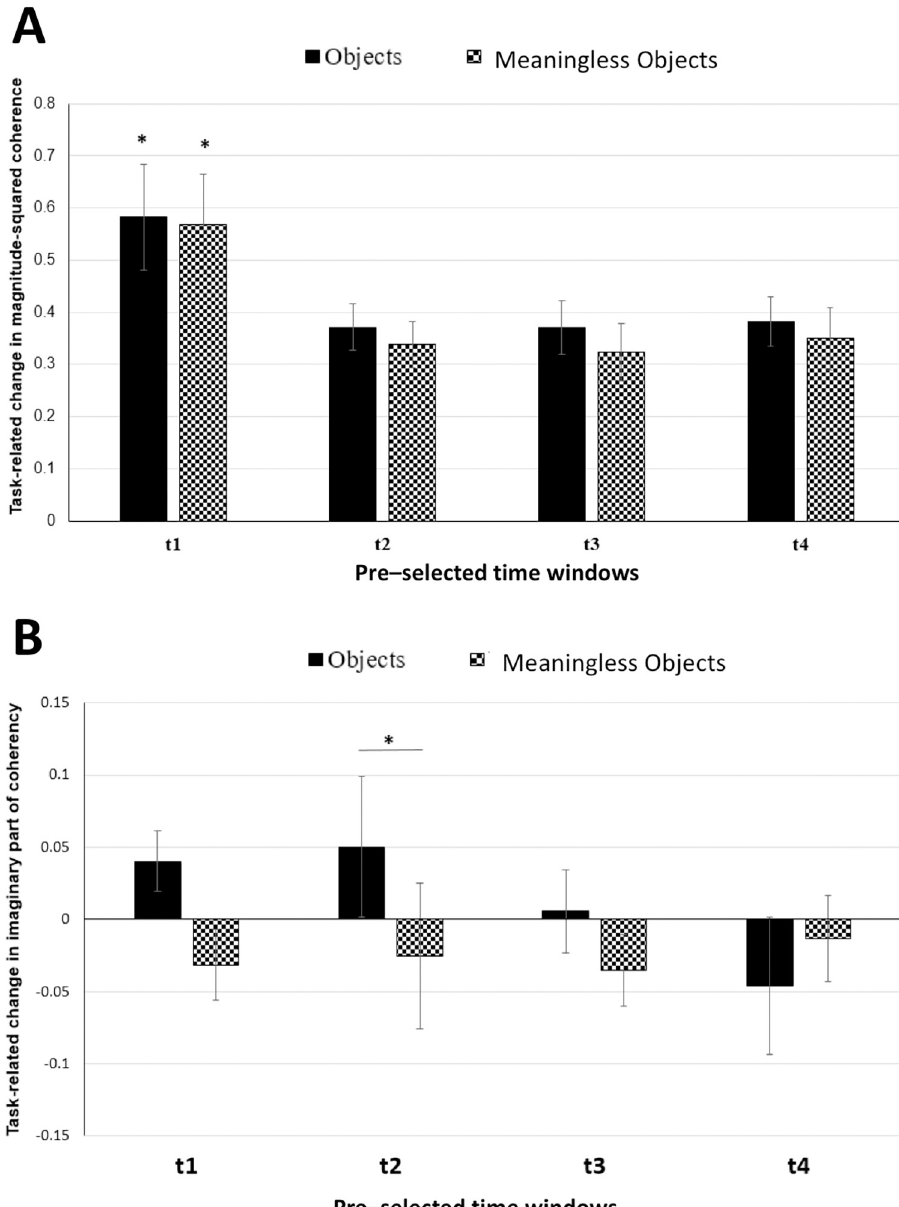
Fig 8. (A) Task-related change in alpha band coherence between the left ROI and right ROI in source space and plotted for four different time windows. Solid black bars represent object stimuli; checked bars represent meaningless object stimuli. t1 = 0–250 ms; t2 = 250–500 ms; t3 = 500–750 ms; t4 = 750–1000 ms. Error bars are SEM. Asterisks indicate p < 0.05. (B) Task-related change in imaginary part of coherency for alpha band between the left ROI and right ROI in source space and plotted for four different time windows. Solid black bars represent object stimuli; checked bars represent meaningless object stimuli. T1 = 0–250 ms; t2 = 250–500 ms; t3 = 500–750 ms; t4 = 750–1000 ms. Error bars are SEM. Asterisks indicate p <